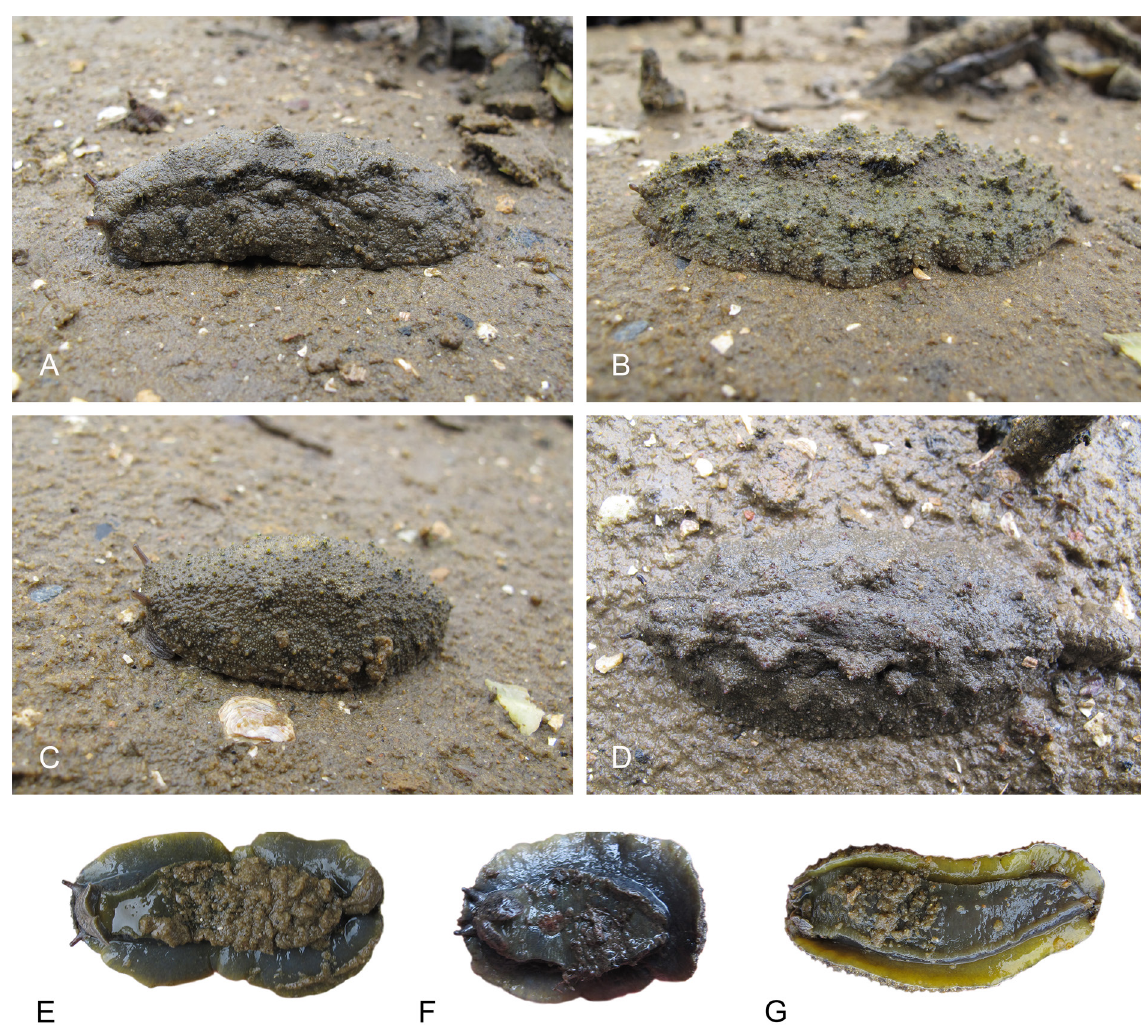
Fig. 26. Paromoionchis daemelii (Semper, 1880) comb. nov., live animals, Australia, New South Wales. A . Dorsal view, 51 mm long [1514] (AM C.468912.002). B . Dorsal view, 56 mm long [1519] (AM C.468917.001). C . Dorsal view, 31 mm long [1515] (AM C.468914.001). D . Dorsal view, 62 mm long [1518] (AM C.468913.001). E . Ventral view, 42 mm long [1512] (AM C.468912.003). F . Ventral view, 36 mm long [1511] (AM C.468910.001). G . Ventral view, same as